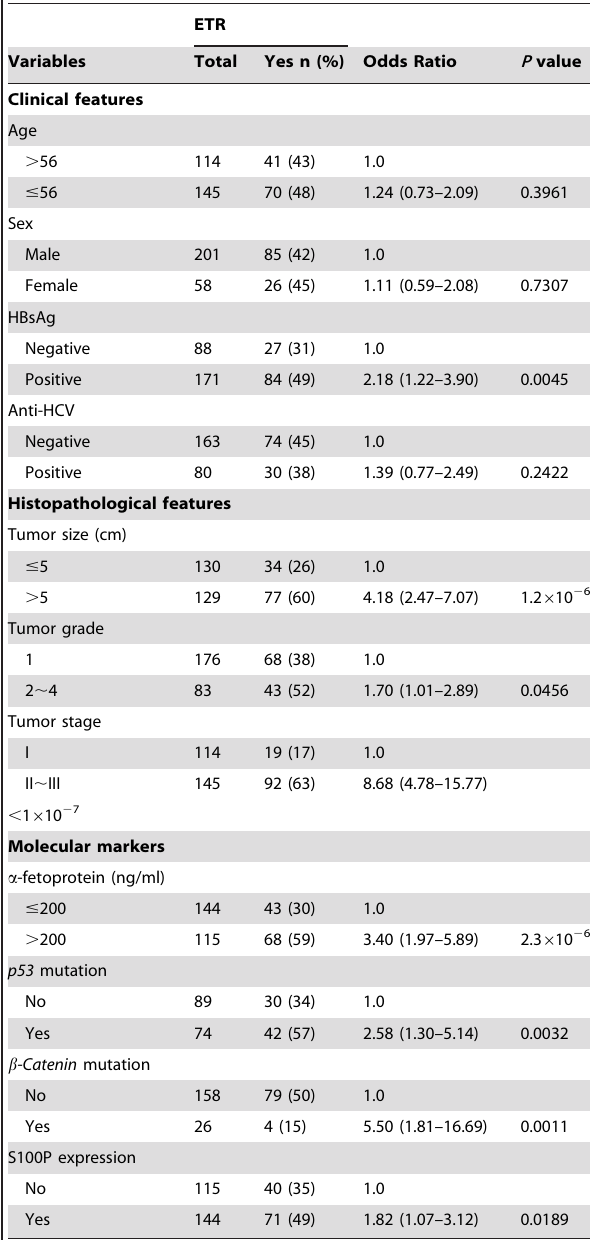
Table 2. Univariate analysis of clinicopathological variables and S100P protein expression with early tumor recurrence (ETR) in patients with surgical removed unifocal primary hepatocellular